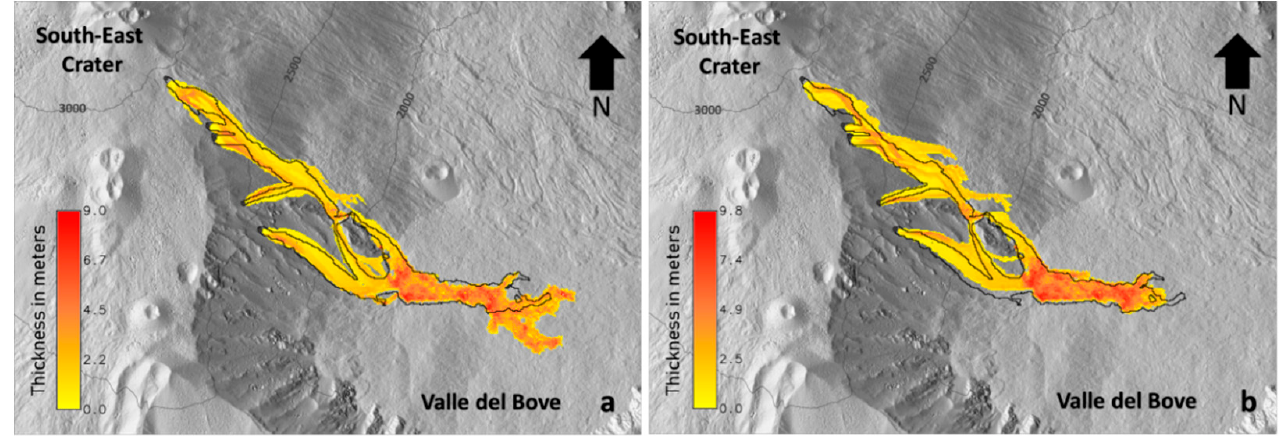
Figure 5. GPUFLOW simulations for the 24–27 December 2018 eruption of the Etna volcano. Lava flows were simulated using the temperature-dependent emissivity without ( a ) and with ( b ) the bias correction. Colors represent the lava flow thickness in meters. The actual lava flow field extracted by the Planetscope image (area of ~1 km 2 ) and the five emission points along the eruptive fissure is highlighted in black. The outline of the actual field was determined by adaptive local thresholding using the free and open-source GRASS GIS software.